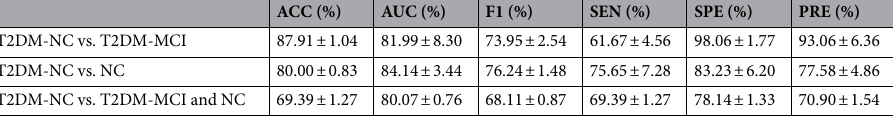
Table 4. Classification performance in T2DM-MCI, T2DM-NC and NC differentiation. ACC accuracy, AUC the area under the receiver operating characteristic curve, SEN sensitivity, SPE specificity, PRE precision.